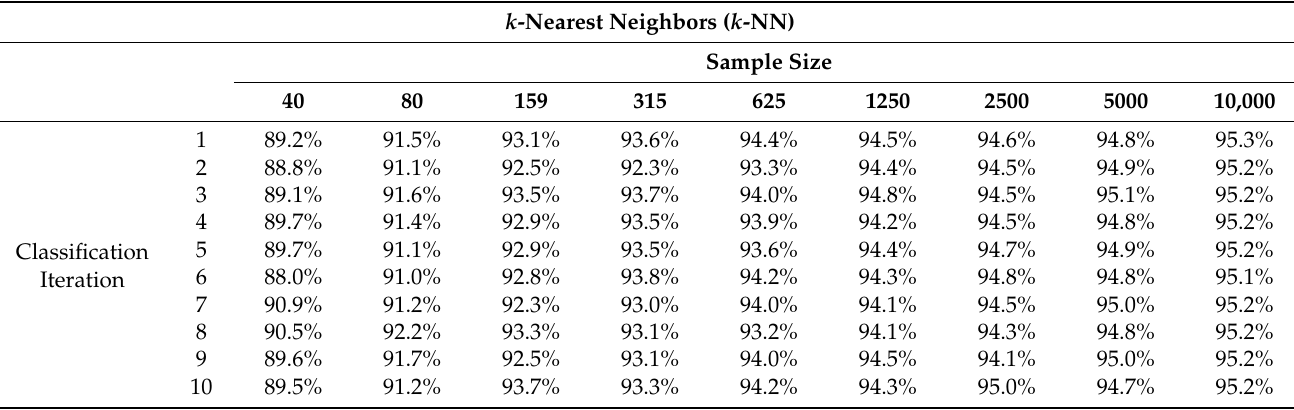
Table A3. Overall Accuracies of k -Nearest Neighbors ( k -NN) Classifications.